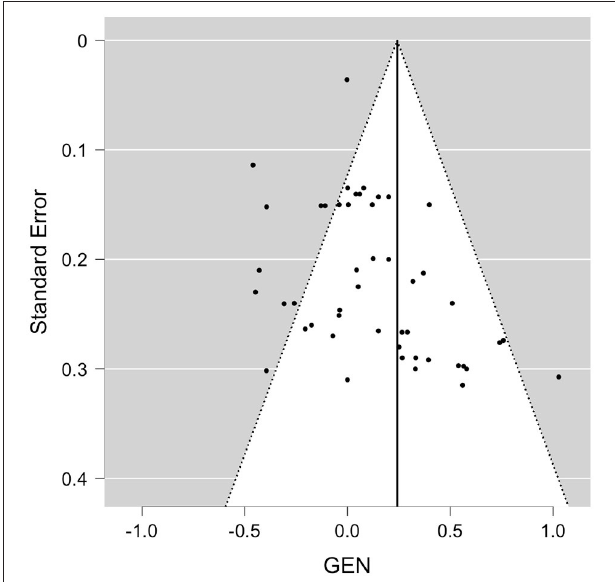
FIGURE 5 | Funnel plot for available study results for EM. GEN, general effect result per study.